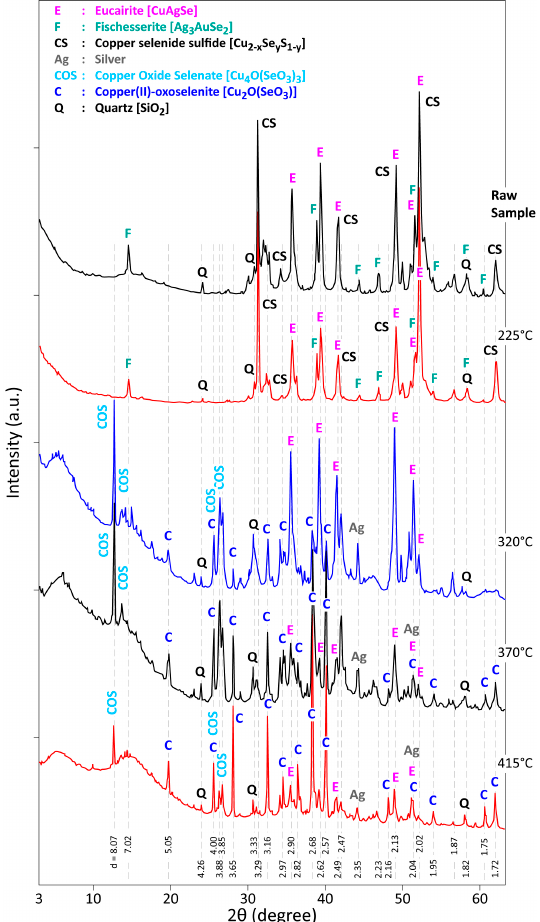
Figure 5. XRD patterns of CAS raw sample and the residues obtained during CAS sample treatment under air, from 225 °C to 415 °C.